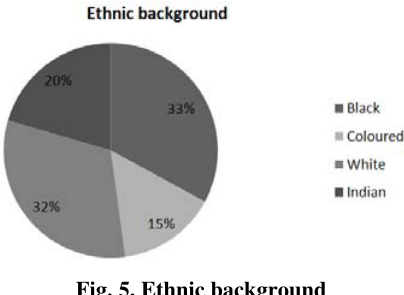
Fig. 5. Ethnic background